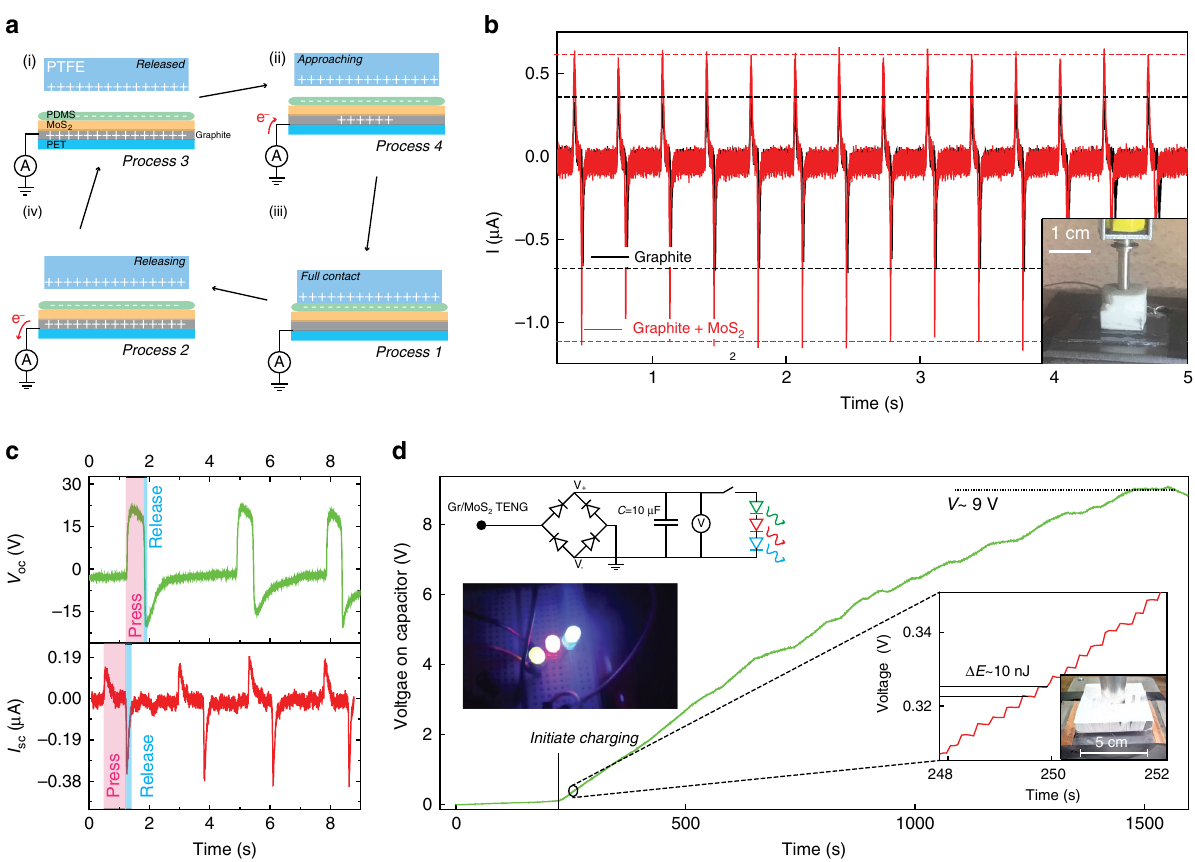
Fig. 4 TENG fi lms based on abraded van der Waals powders. a Schematic showing the evolution of charge within the device during a charging/ discharging cycle. b Current response through a 1 M Ω resistor for an abraded graphite TENG electrode (black) compared with an abraded graphite – MoS 2 TENG heterostructure electrode (red). (Inset: PTFE hammer connected to a linear actuator used to generate the voltage pulses). c Top: temporal response of the open circuit voltage and bottom: temporal response of the short circuit current, for the graphite – TMDC TENG electrode. d Voltage accumulation on a capacitor vs time (hammer frequency ~ 3 Hz). Inset top: rectifying circuit used to charge the capacitor. Inset middle left: three glowing LED ’ s during discharge of the capacitor. Inset right: zoomed in region of the charging curve highlighting the energy stored on the capacitor per